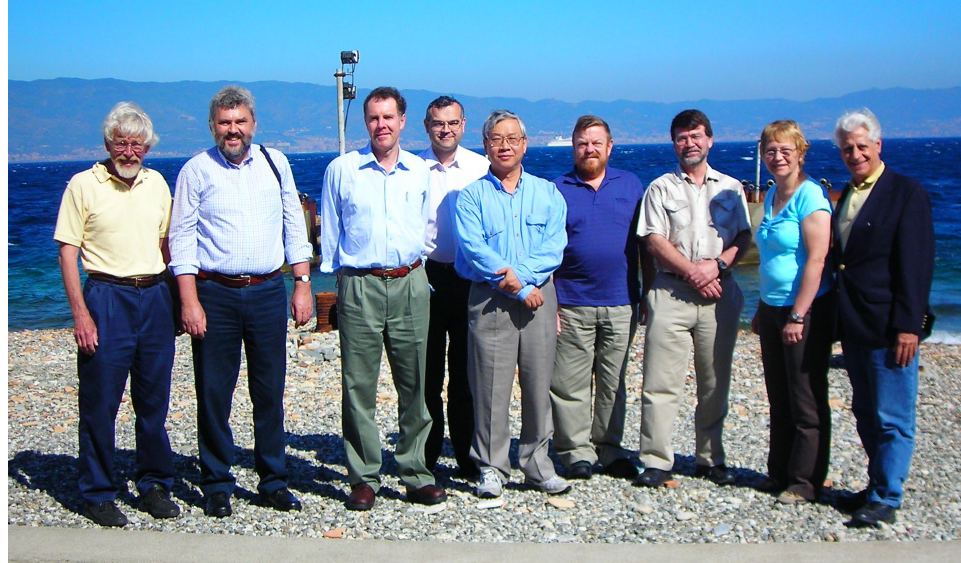
Figure B2. Participants from left to right: Giles M. Marion (USA), Rainer Feistel (Germany), Trevor J. McDougall (Australia), Brian A. King (UK), Chen-Tung Arthur Chen (Taiwan), David Jackett (Australia), Daniel G. Wright (Canada), Petra Spitzer (Germany), Frank J. Millero (USA). Photo taken at the shore of the Strait of Messina, with the island of Sicily in the background.